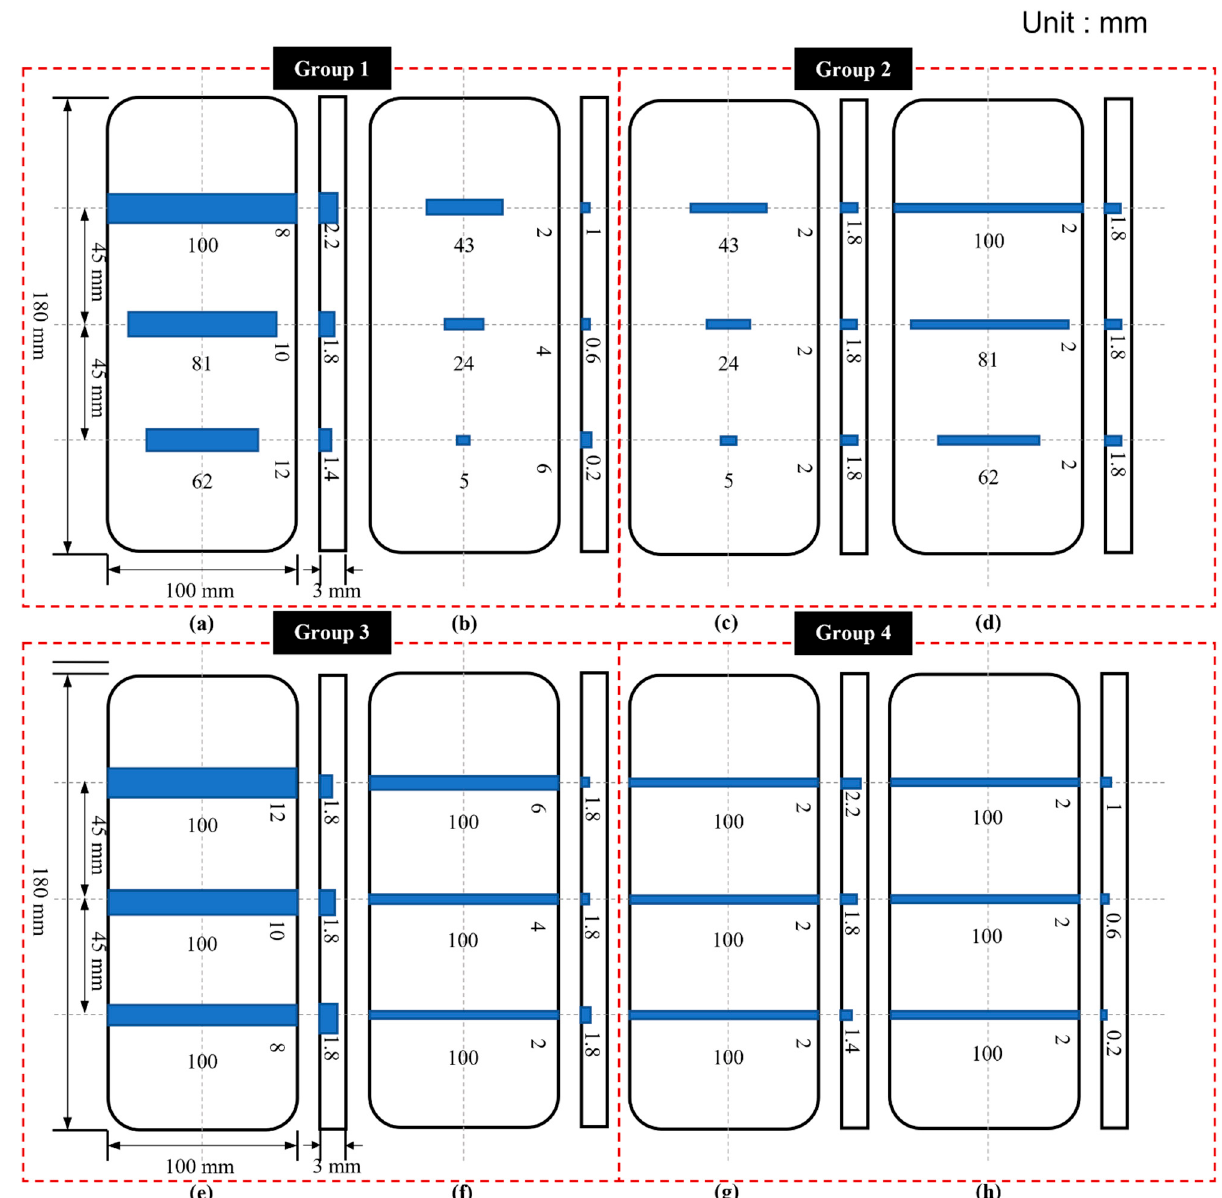
Figure 4. Schematic of the polypropylene composite sample considering various defect conditions, ( a , b ) according to composite defect (group 1); ( c , d ) according to length (group 2); ( e , f ) according to width (group 3); ( g , h ) according to depth (group 4).